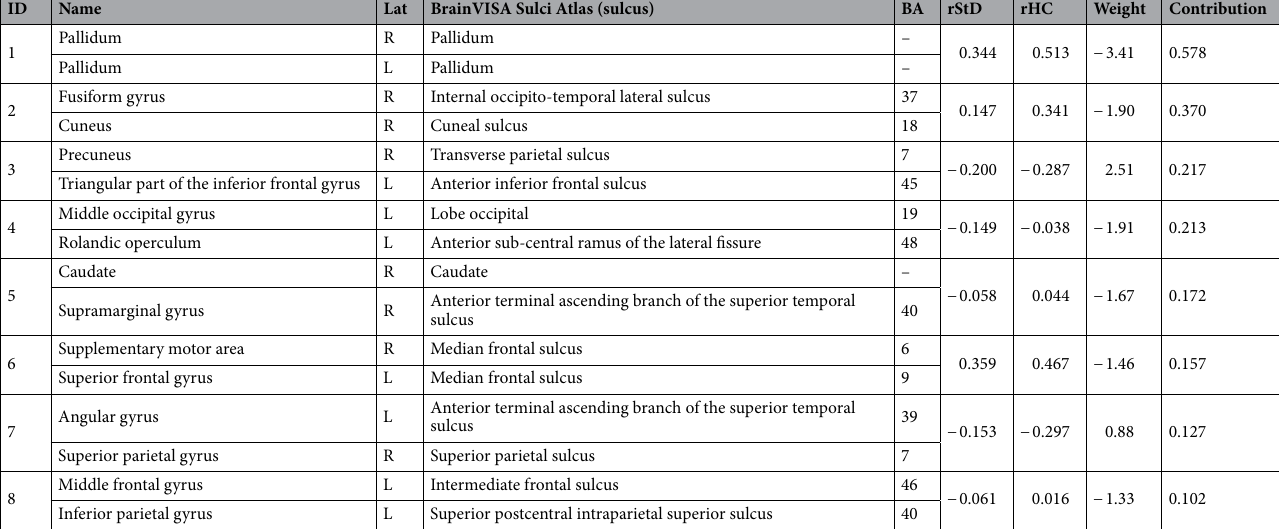
Table 2. Characteristics of the eight interregional functional connections (FCs) used in the subthreshold depression (StD) classifier. The mean functional correlation values for StD (rStD) and healthy controls (rHC) are presented for individual FCs. Since the StD group was the positive class in the classification of the StD and HC populations, the sign of weight was positive when rStD > rHC, whereas it was negative when rStD < rHC. Contribution was computed as (rStD − rHC) × weight. BA Brodmann area.